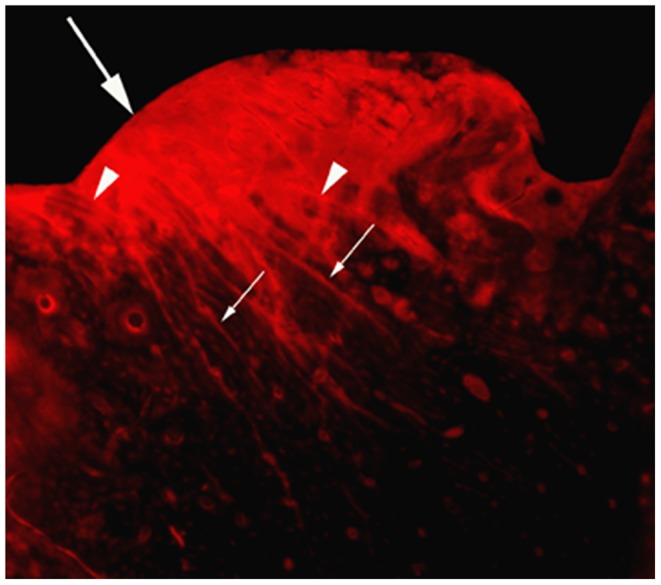
Microdamage in peri-screw bone stained with basic fuchsin.Diffuse damage was contacted with bone edge (large arrow), behind which larger linear cracks (small arrows) were visible. Linear cracks often mixed with diffuse damage (arrow heads) in the area adjacent to the bone-screw interface.